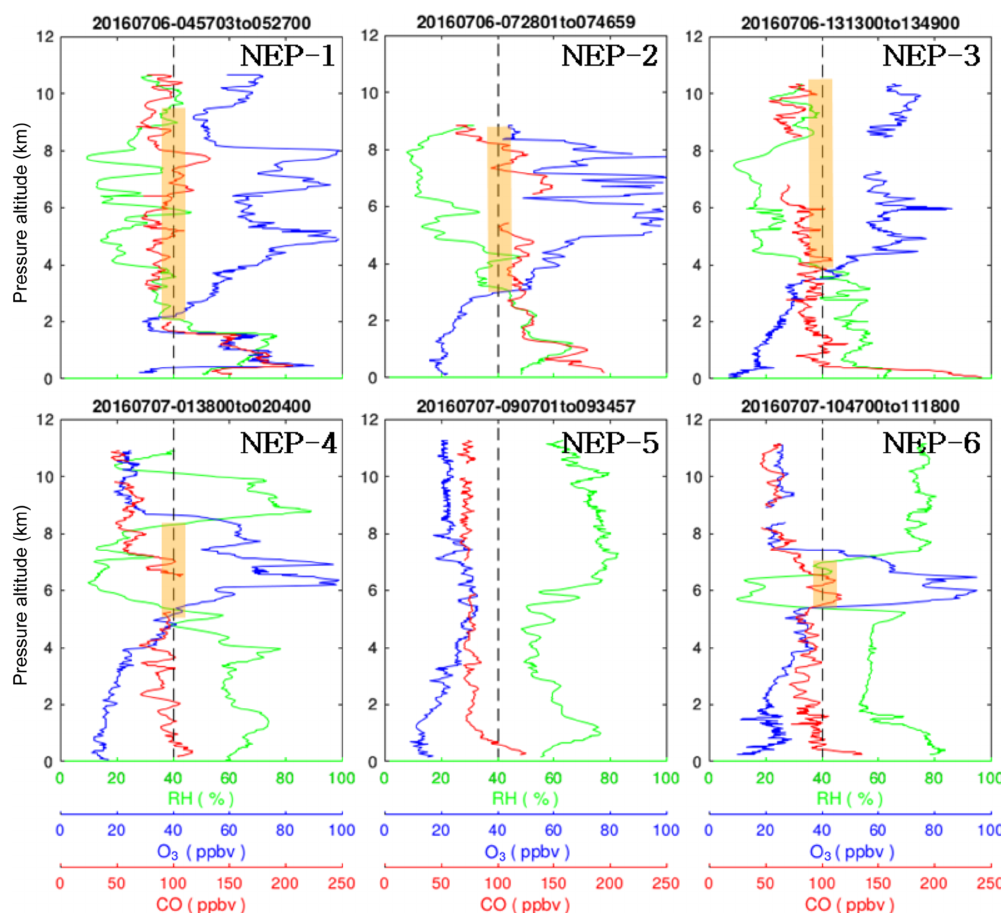
Figure 6. Vertical profiles of relative humidity RH (green curves; in %), ozone O 3 (blue curves; in parts per billion by volume – ppbv) and carbon monoxide CO (red curves; in ppbv) from the six take-offs from and landings to TPE of IAGOS aircraft on 6–7 July shown in Fig. 5. The dashed line is an arbitrary limit separating dry ( RH<40%) and moist (RH>40%), O 3 -poor (<40ppbv) and O 3 -rich (>40ppbv), and CO-poor (<100ppbv) and CO-rich (>100ppbv) air masses. Thick orange segments indicate regions with dry and O 3 -rich